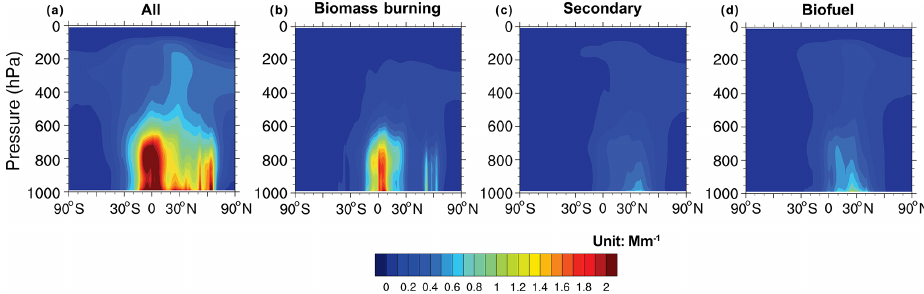
Figure 9. Simulated zonal averaged annual mean BrC absorption at 365nm (Mm − 1 ) for (a) all sources, (b) biomass burning emissions, (c) secondary BrC formation and (d) biofuel BrC emissions. The unit is Mm − 1 . The colored bar is in log scale.